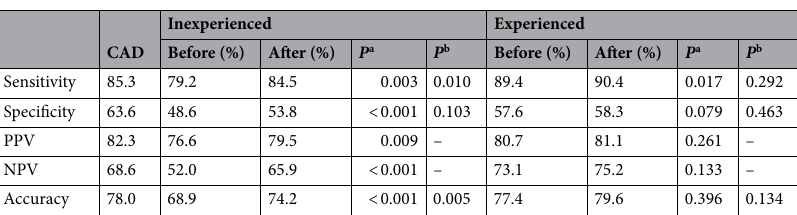
Table 3. Diagnostic performance of physicians with different levels of experience before and after CAD assistance. ACR-TIRADS 4 was used as the cut-off to calculate the diagnostic performance of physicians. CAD, computer-aided diagnosis; Before, physicians before CAD assistance; After, physicians after CAD assistance. PPV, positive predictive value; NPV, negative predictive value. P a , CAD vs. before; P b , before vs. after.